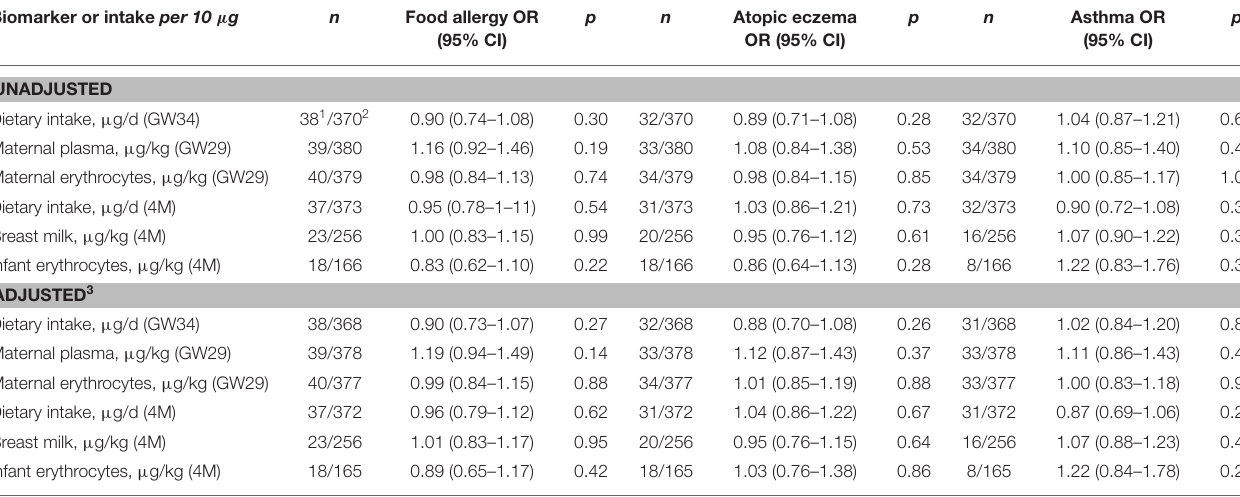
TABLE 6 | Logistic regression analyses of selenium status with infant allergy diagnosis at 12 months of age. Biomarker or intake per 10 µ